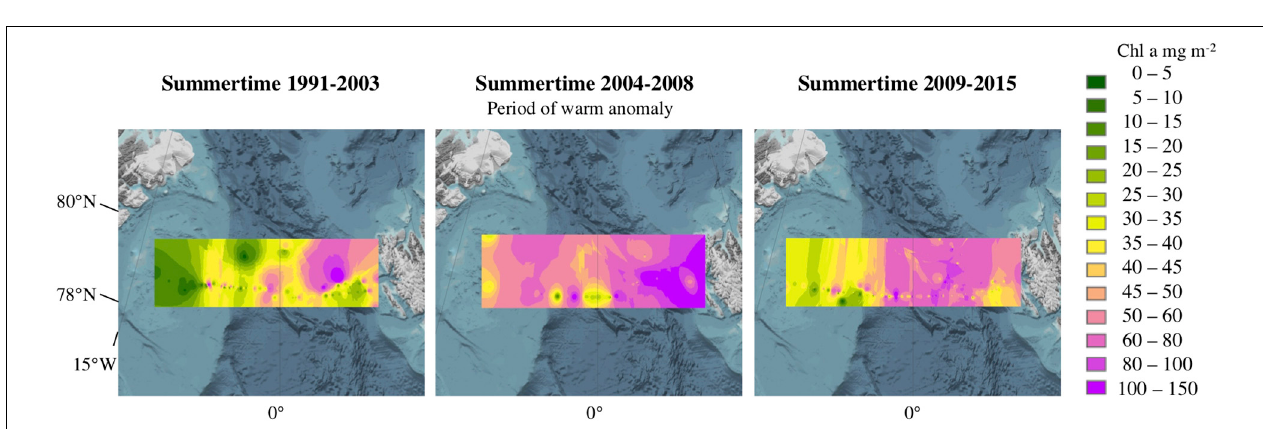
FIGURE 7 | Upper: Sea ice extent for investigated years during September and August, small dots indicate stations; lower: comparison of POC integrated 0–100 m water depth obtained in August and, September 1993 – 2015 (8 expeditions) at different latitudes ( ◦ N) in the central Arctic Ocean (85 ◦ –90 ◦ N, 80 ◦ –85 ◦ N and < 80 ◦ N). Data are available only for < 80 ◦ N for 1993, < 80 ◦ N and from 80 ◦ to 85 ◦ N for 1995, and from 80 ◦ to 85 ◦ N for 2008. Sea ice concentration were obtained from http://www.meereisportal.de (grant: REKLIM-2013-04); (Spreen et al.,